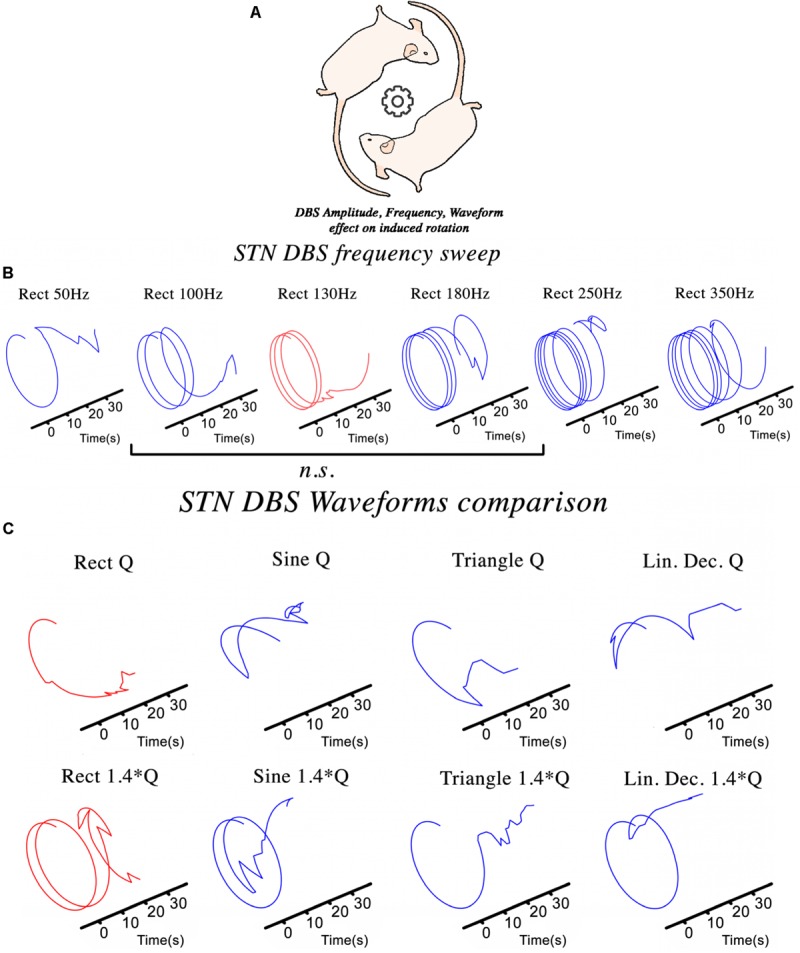
The NES STiM was utilized in different experimental studies using a hemi-PD rat model. (A) An assessment of the effect of STN-DBS parameters on the induced rotational behavior of the PD rats; (B,C) The impact of frequency and waveform on the induced rotation caused by stimulation.